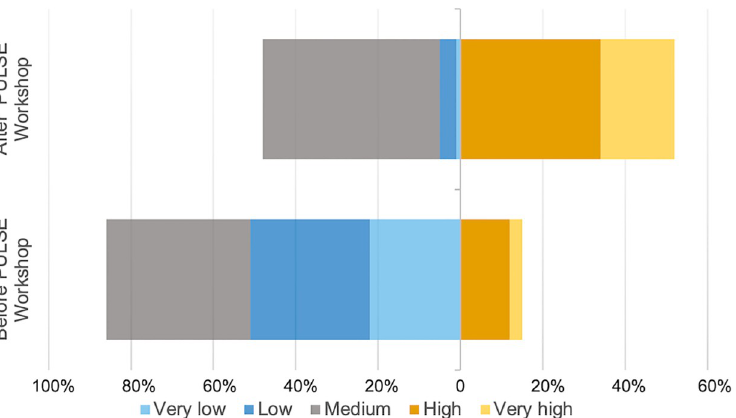
Fig 6. Change in participants’ perceived knowledge of systems thinking. Percentage of participants (n = 77) reporting very low, low, medium, high or very high levels of systems thinking. The percentage of participants reporting high or very high levels of knowledge (orange) increased from before the PULSE workshop (bottom bar) to after the workshop (top bar, (p < 0.001, df = 4)).